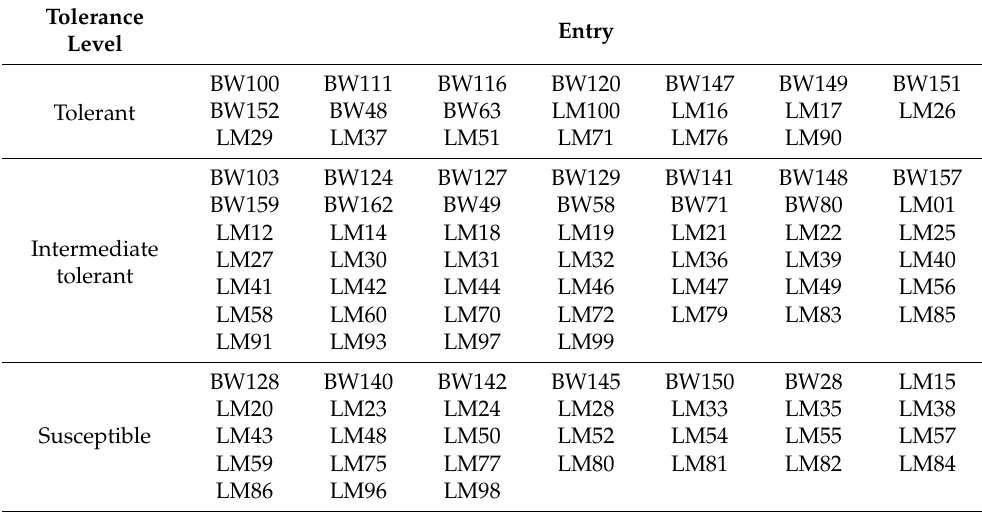
Table 1. Population groups based on observed drought tolerance levels of individual genotypes based on grain yield under drought